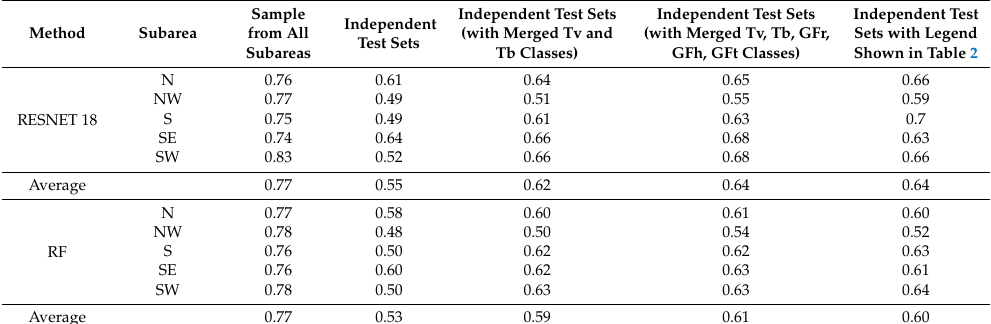
Table 3. Results of accuracy assessment for different scenario and legends.